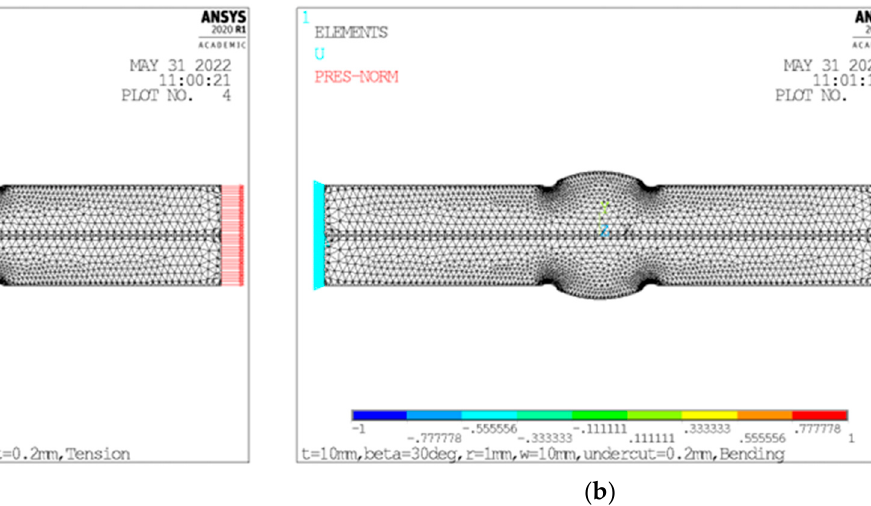
Figure 3. Finite element mesh and applied boundaries for the load case: ( a ) tension; ( b ) bending.